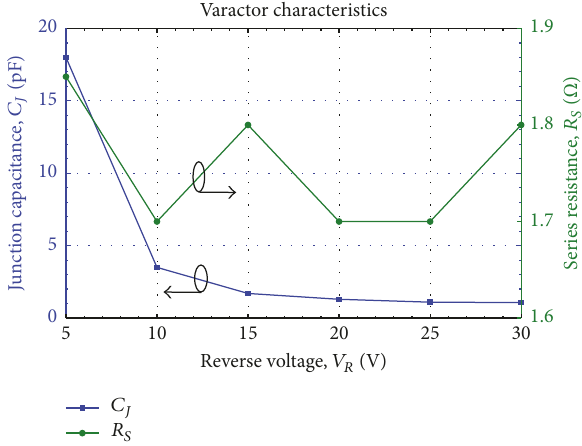
Figure 4: Junction capacitance 𝐶 𝐽 and series resistance 𝑅 𝑆 as function of the reverse voltage 𝑉 𝑅 . The values were extracted from themeasured 𝑆 -parameters.While 𝑅 𝑆 maintainsarelativelyconstant value within the entire voltage sweep, the capacitance 𝐶 𝐽 exhibits a larger dynamic range when 𝑉 𝑅 ≤ 10